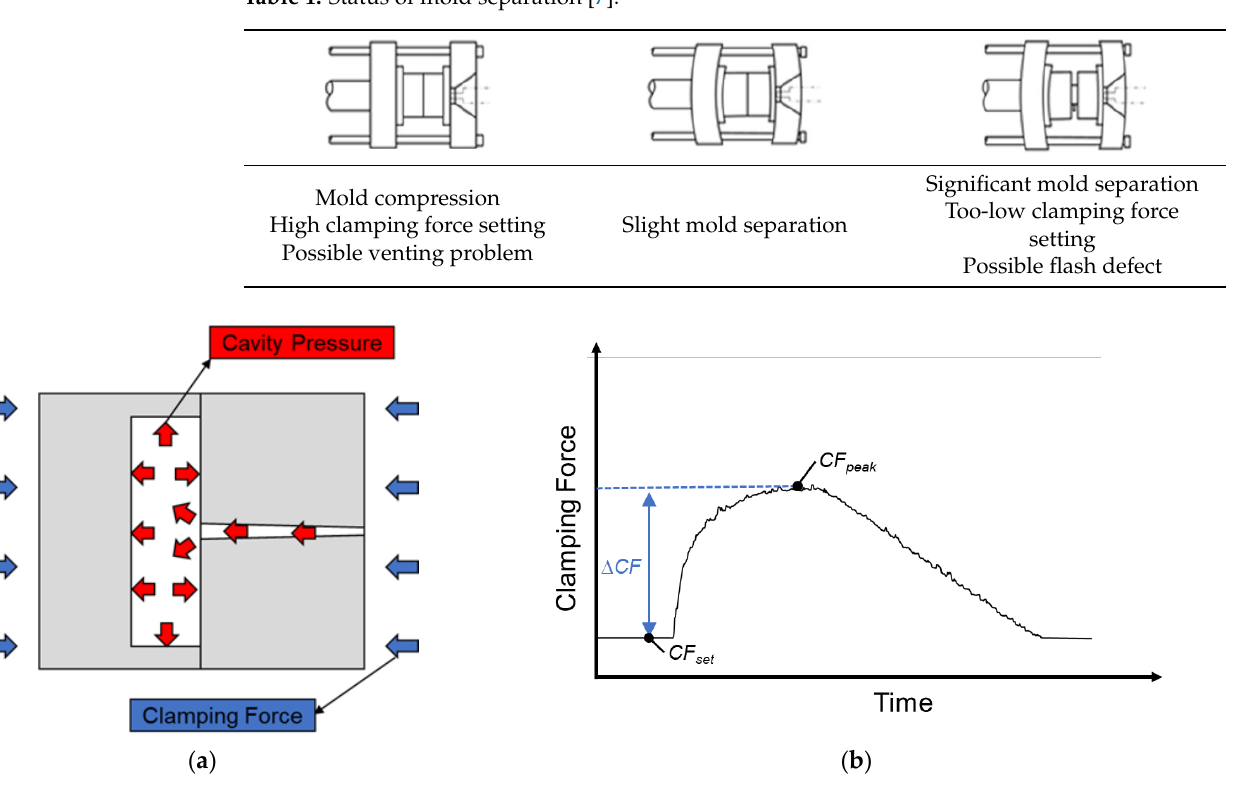
Figure 5. ( a ) Relationship between cavity pressure and clamping force. ( b ) Clamping force difference value [14].